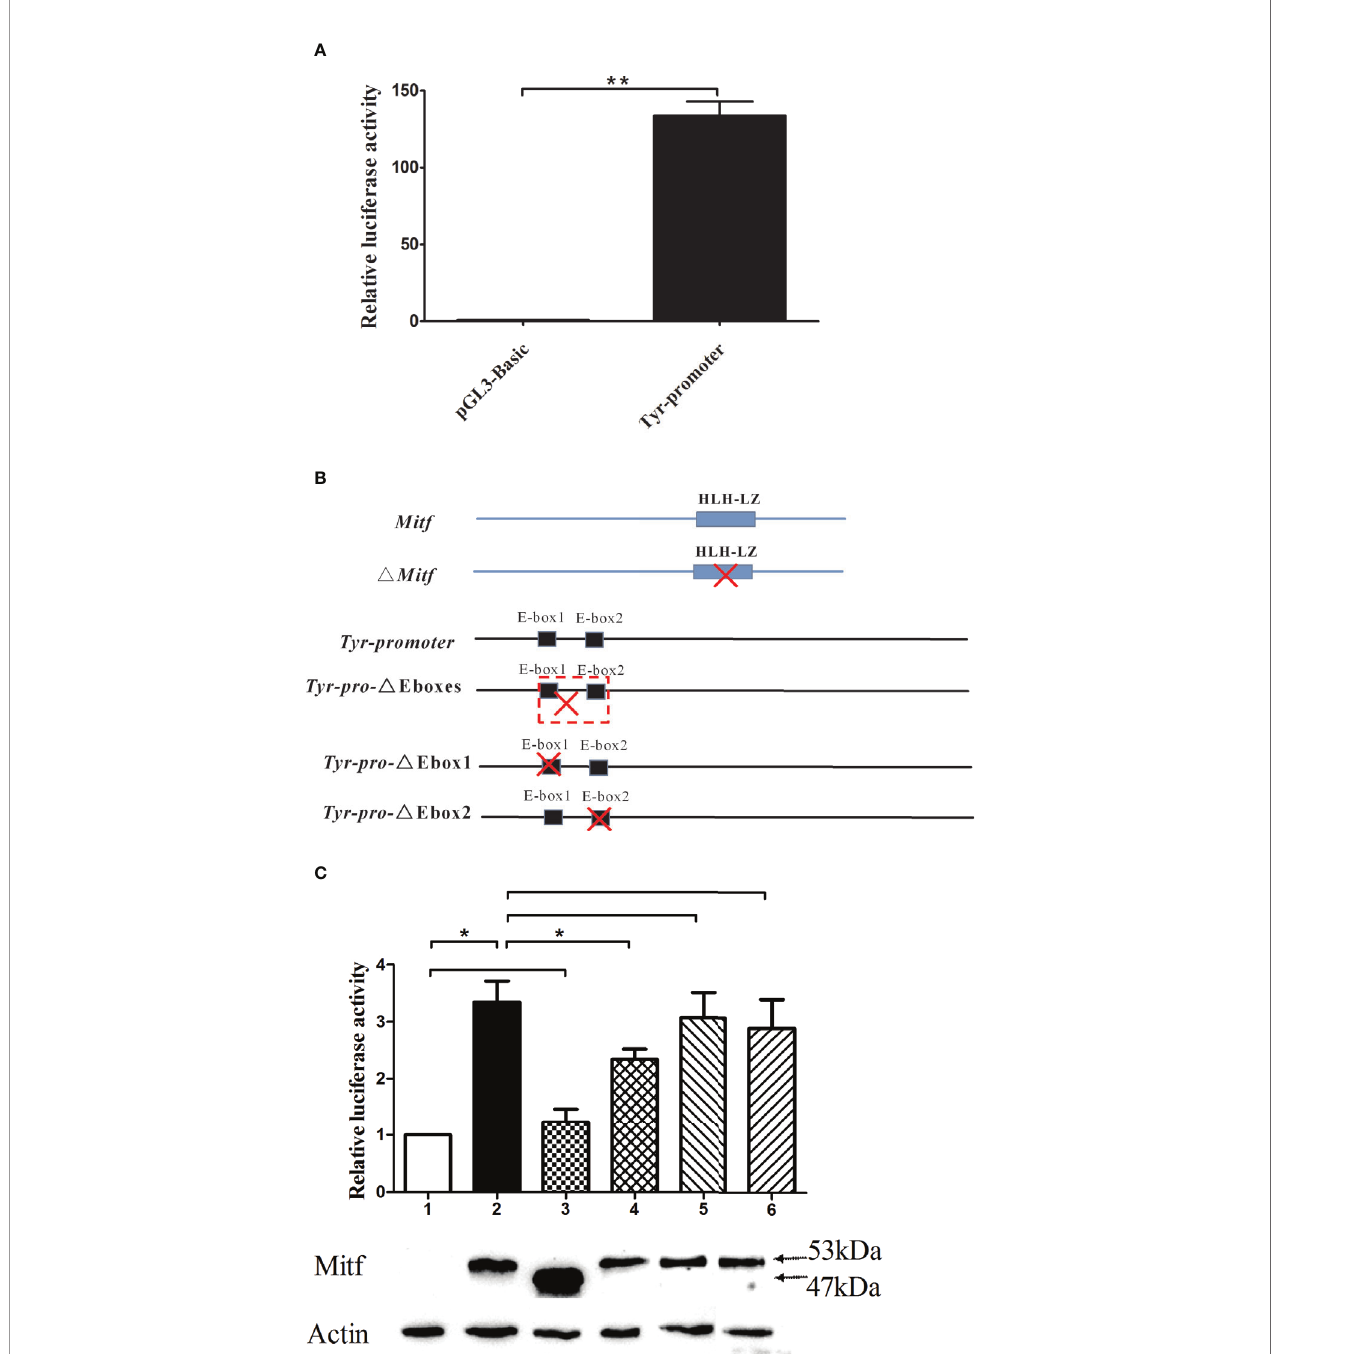
FIGURE 8 | The PpTyr promoter activity was induced by PpMitf . (A) PpTyr promoter activity analysis. The 293T cells in 24-well plates were transfected with 0.4 m g of Tyr-promoter-Luc (pGL3-Basic in control) and 0.04 m g pRL-cmv vector. 48 h post transfection, cells were collected for luciferase activity assays. (B) The construction of Mitf -pcDNA3.1, Mitf- △ HLHLZ-pcDNA3.1, Tyr- △ Eboxes-promoter-Luc, Tyr- △ Ebox1-promoter-Luc and Tyr- △ Ebox2-promoter-Luc plasmids. (C) The function analysis of HLHLZ domain in MITF and E-box in Tyr promoter by luciferase activity analysis and western blot. Column and lane 1, the 293T cells were cotransfected with pcDNA3.1 and Tyr-promoter-Luc vector; Column and lane 2, Mitf -pcDNA3.1 and Tyr-promoter-Luc; Column and lane 3, Mitf- △ HLHLZ- pcDNA3.1 and Tyr-promoter-Luc; Column and lane 4, Mitf -pcDNA3.1 and △ Eboxes-promoter-Luc; Column and lane 5, Mitf -pcDNA3.1 and △ Ebox1-promoter- Luc; Column and lane 6, Mitf -pcDNA3.1 and △ Ebox2-promoter-Luc. The data were represented as the mean ± SD ( N = 5). * P < 0.05; ** P < 0.01; No signal means no